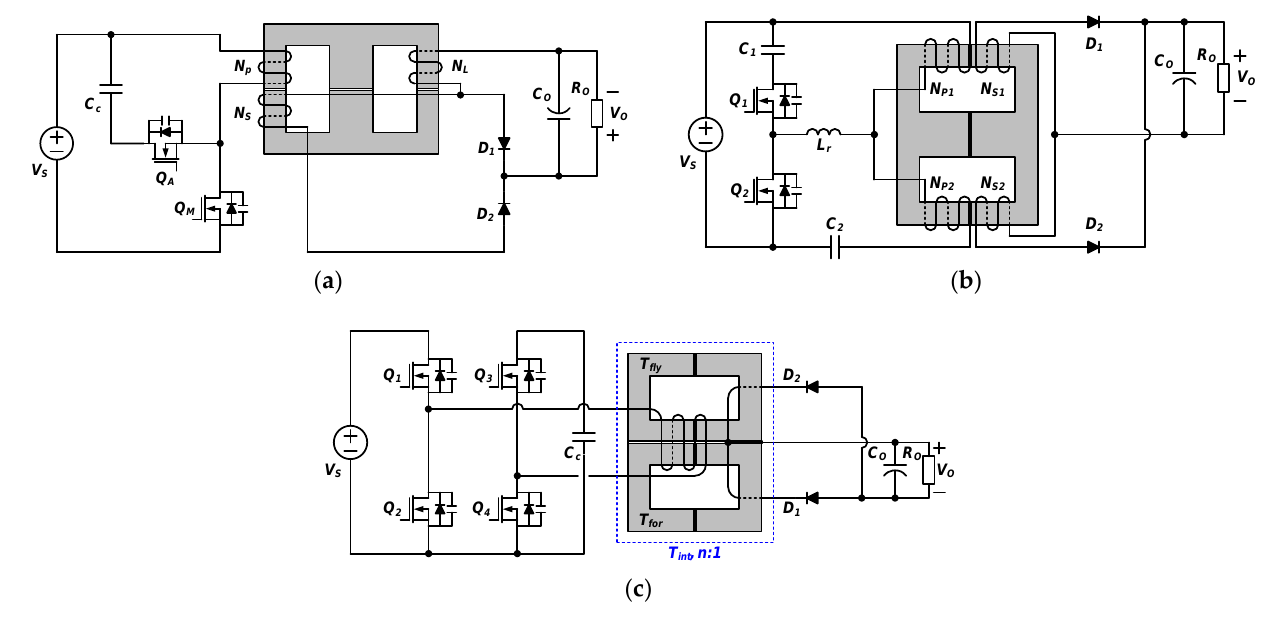
Figure 3. Conventional converters with integrated transformer: ( a ) Integration of a transformer and an output inductor. ( b ) Integration of two transformers and windings wound outside the core. ( c ) Integration of two transformers sharing primary windings.